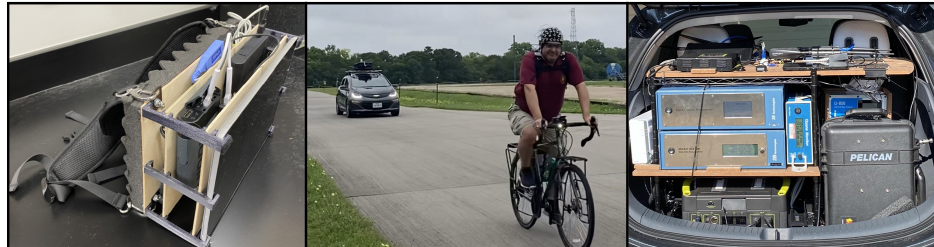
Figure 4. Data collection images. ( Left ) custom-made backpack to house biometric devices and recording computer; ( middle ) participant and environmental survey vehicle riding in tandem during data collection; ( right ) environmental sensors organized in trunk of electric survey